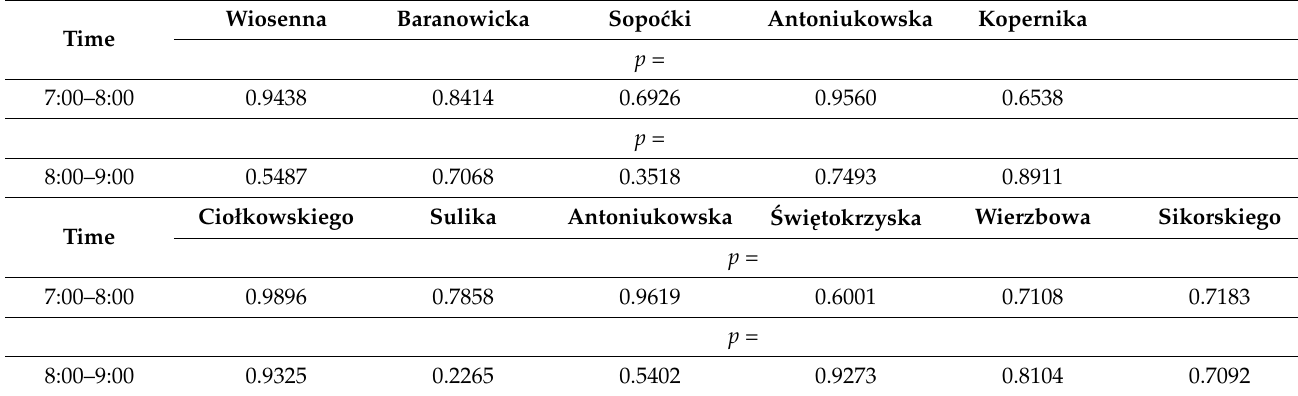
Figure 4. Hourly traffic intensity on main routes ( a ) 7:00–8:00 ( b ) 8:00–9:00. Table 2. ANOVA results of daily traffic intensities